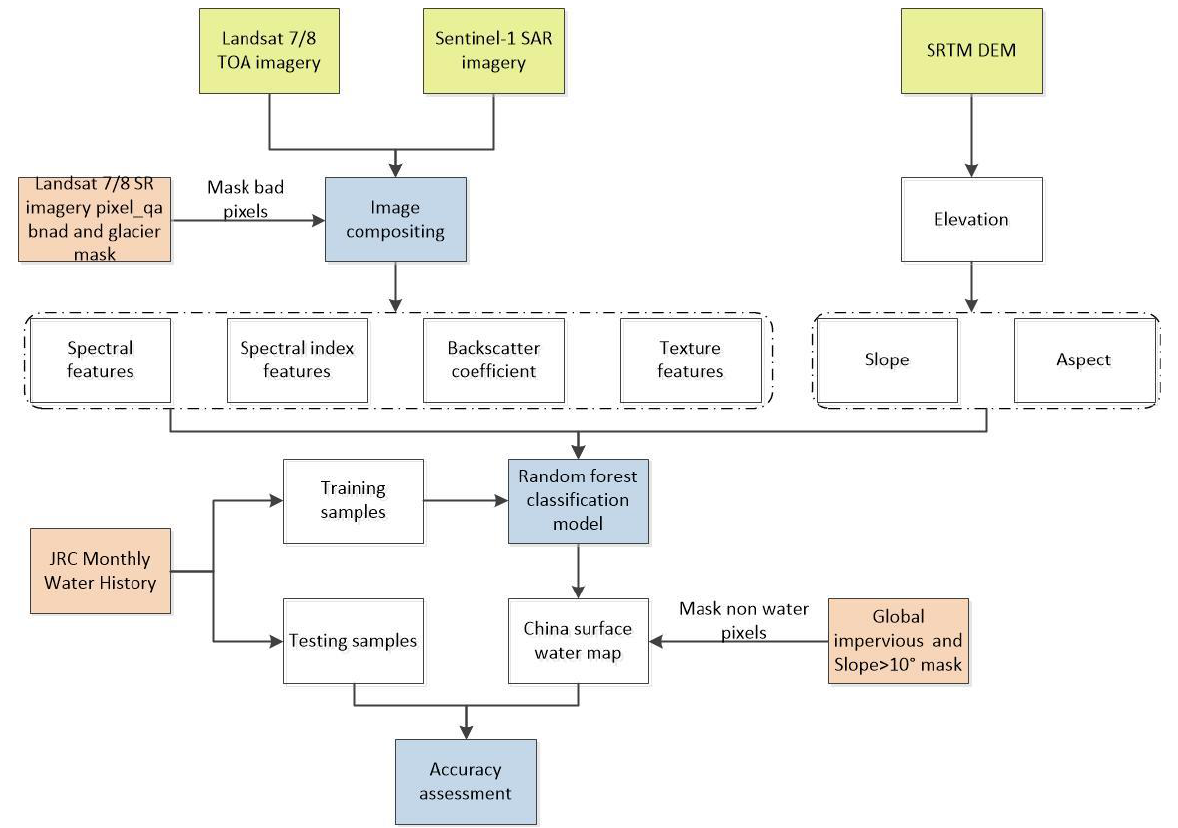
Figure 2. Workflow of large-scale surface water extraction based on GEE. The light-yellow boxes indicate the raw input data, the orange boxes indicate the third-party auxiliary data, and the blue boxes indicate the processing done to the data.